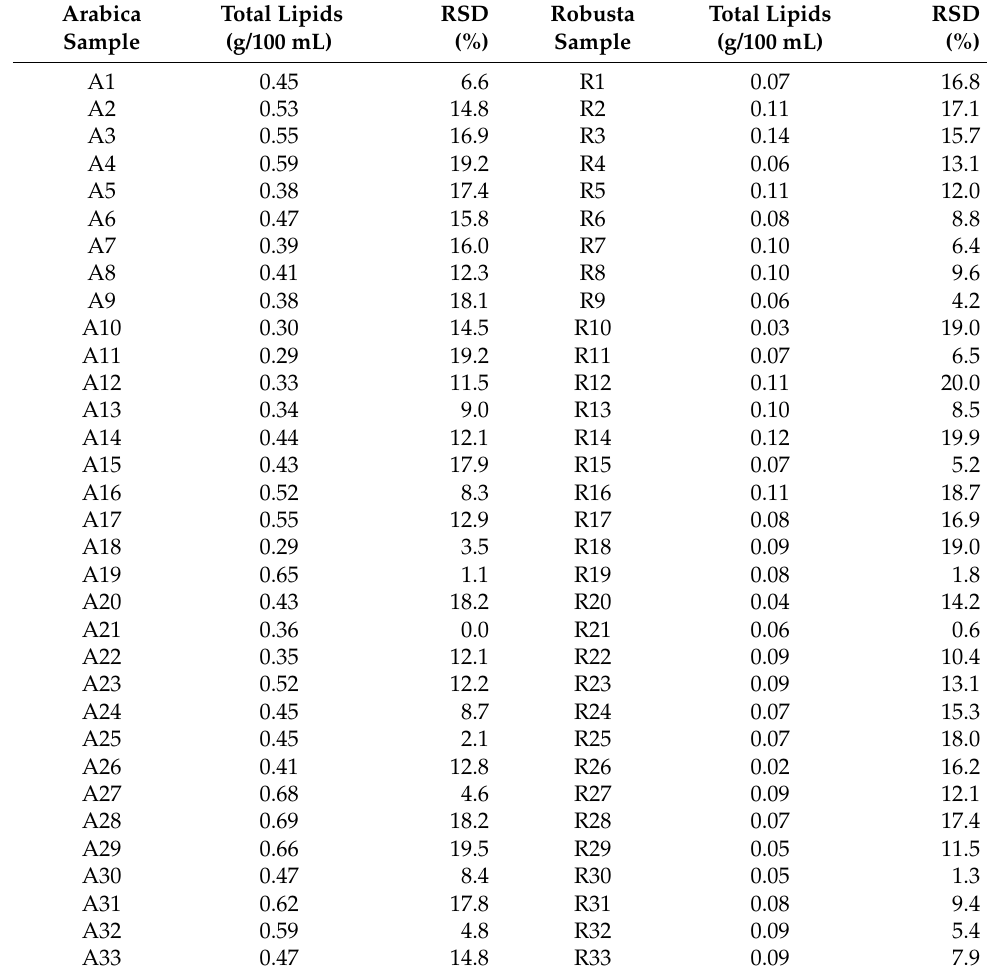
Table 3. Lipid contents (g/100 mL) found in different EC samples, Arabica and